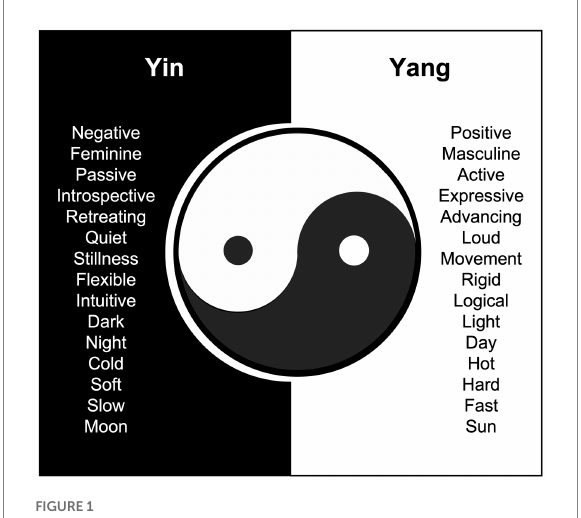
FIGURE 1 Yin-Yang symbol and